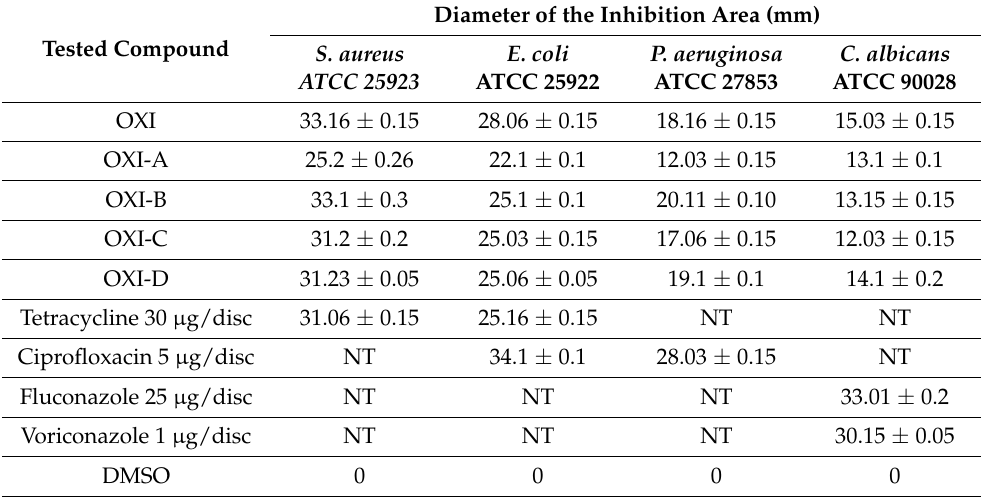
Table 3. Diameter of the inhibition area of the tested compounds (NT= not tested).